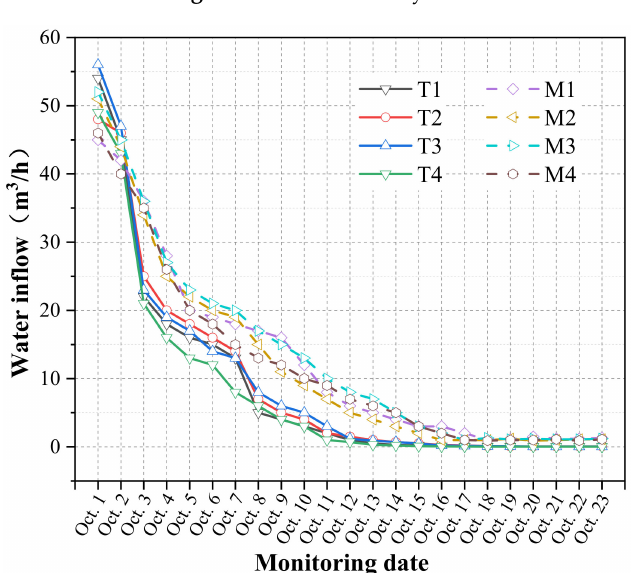
Figure 24. Water inflow curve of inspection